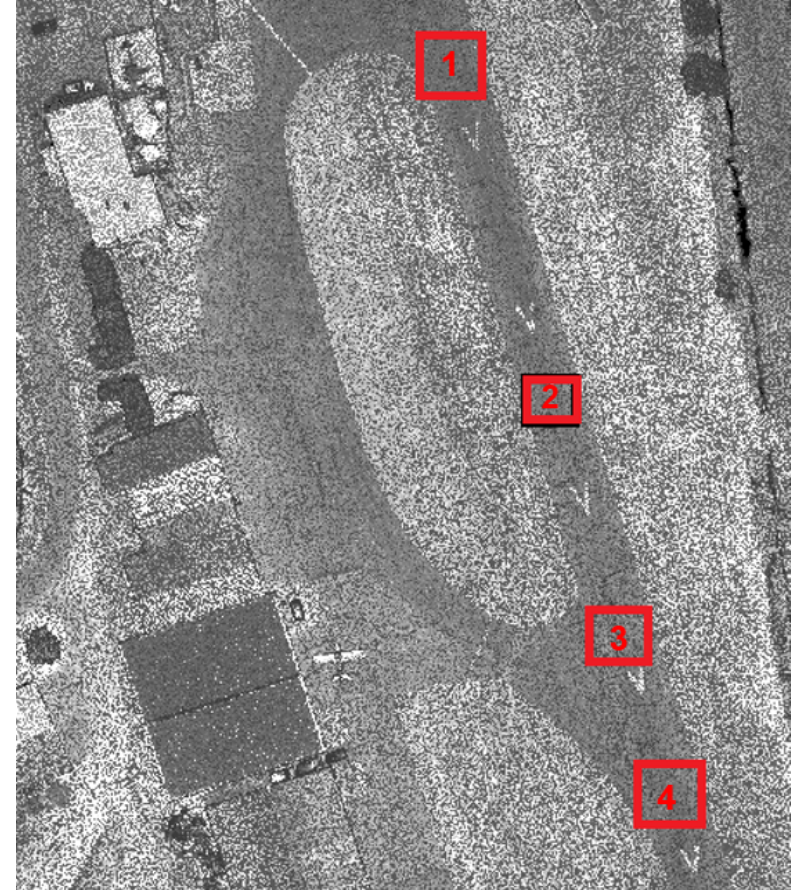
Figure 3. The four selected small target areas located on the airfield that were used for the amplitude calibration a ref